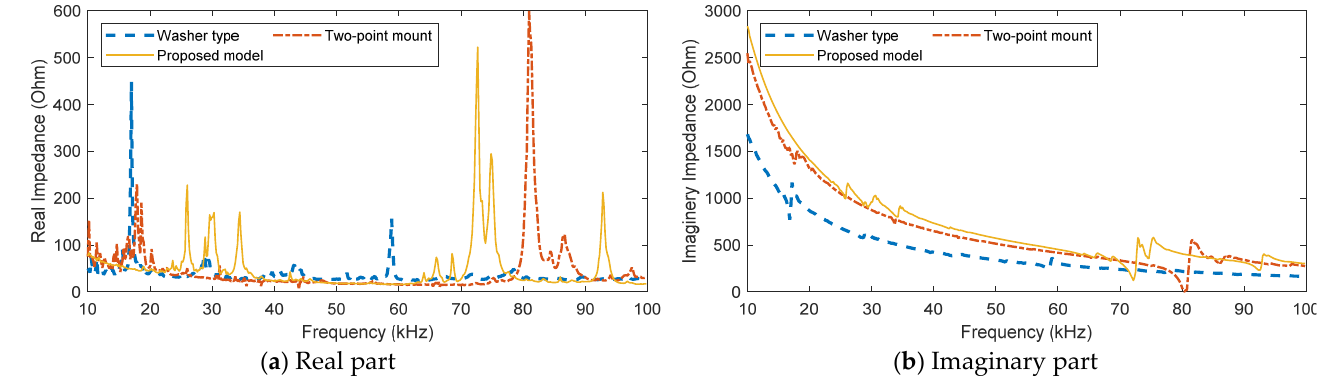
Figure 9. Measured electromechanical impedance responses of three PZT interface models.